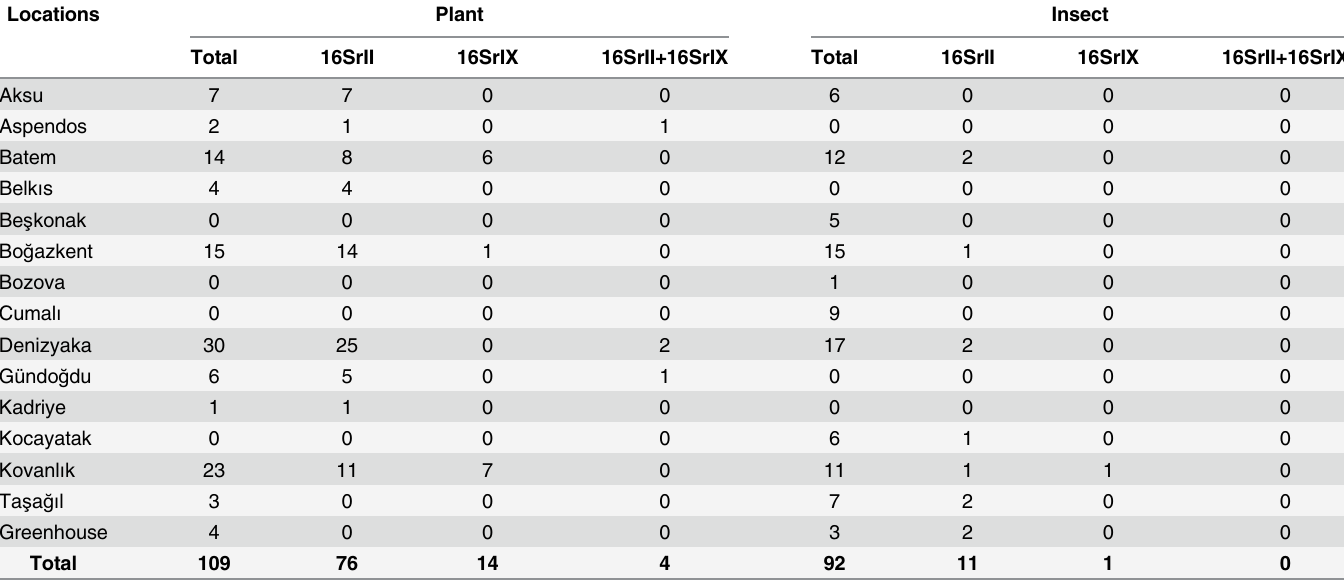
Table 1. Multiplex qPCR detection of 16SrII and 16SrIX group phytoplasmas in plant and insect samples collected from different locations of Antalya province in Turkey.